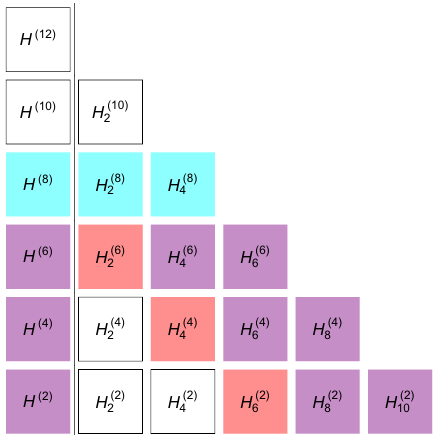
Figure 19 . This (cid:12)gure shows a half-completed computation with max order q 12 ; each cell H ( k ) i represents 2 to 4 distinct terms H ( k ) m with m l n l = i . The cyan row, order q 8 , is currently being l n l computed, and the red diagonal contains the terms which are being used in the computation of the cyan row. The purple cells have already been computed and are being stored for future use, and the white cells have not been computed yet or have been deleted to save RAM. The row with k = 0 (which would be at the bottom) contains the seed terms H (0) = H (0) m;n = 1 and is not